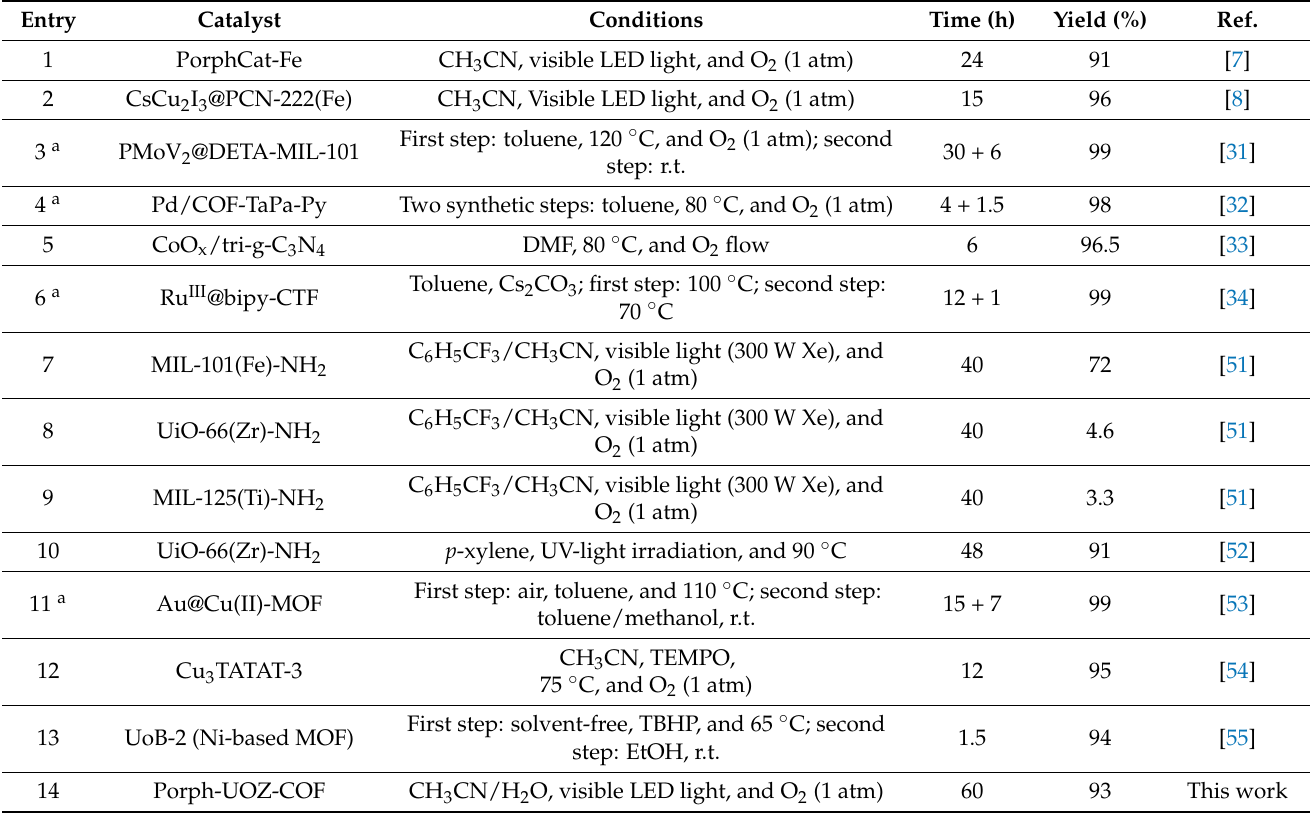
UOZ-COF (20 mg) as multifunctional catalyst. b Isolated yield. Table 3. Reaction between benzyl alcohol and malononitrile over different